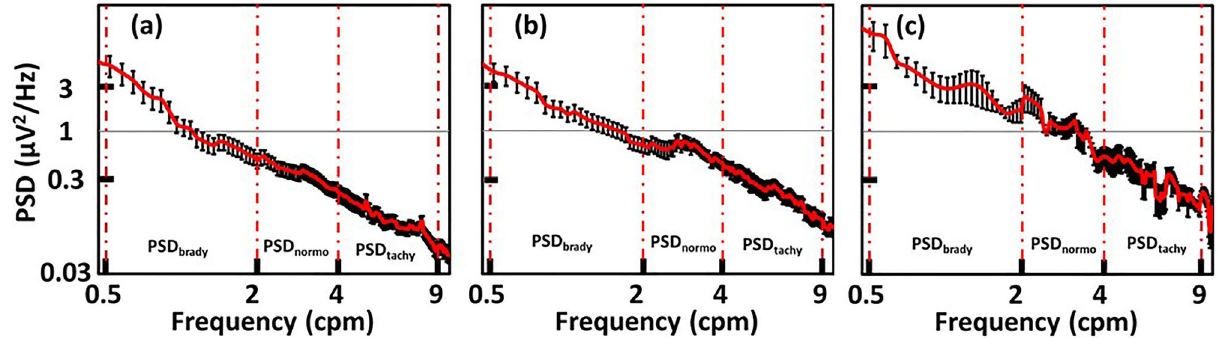
Figure 2. Power spectral density (PSD) plots from different gestational age groups. An example of group- averaged PSD plots taken from ( a ) early GA ( n = 25), ( b ) mid-GA ( n = 22), and ( c ) term infants ( n = 4) in the During-feed period averaged between Feeding 1 and Feeding 2. X-axis is the GR frequency of EGG in cpm, and y-axis is the power spectral density in μV 2 /Hz. The red vertical lines mark the GR frequency bands of bradygastria (brady), normogastria (normo), and tachygastria (tachy). The error bars represent the standard error of the mean from four term infants.